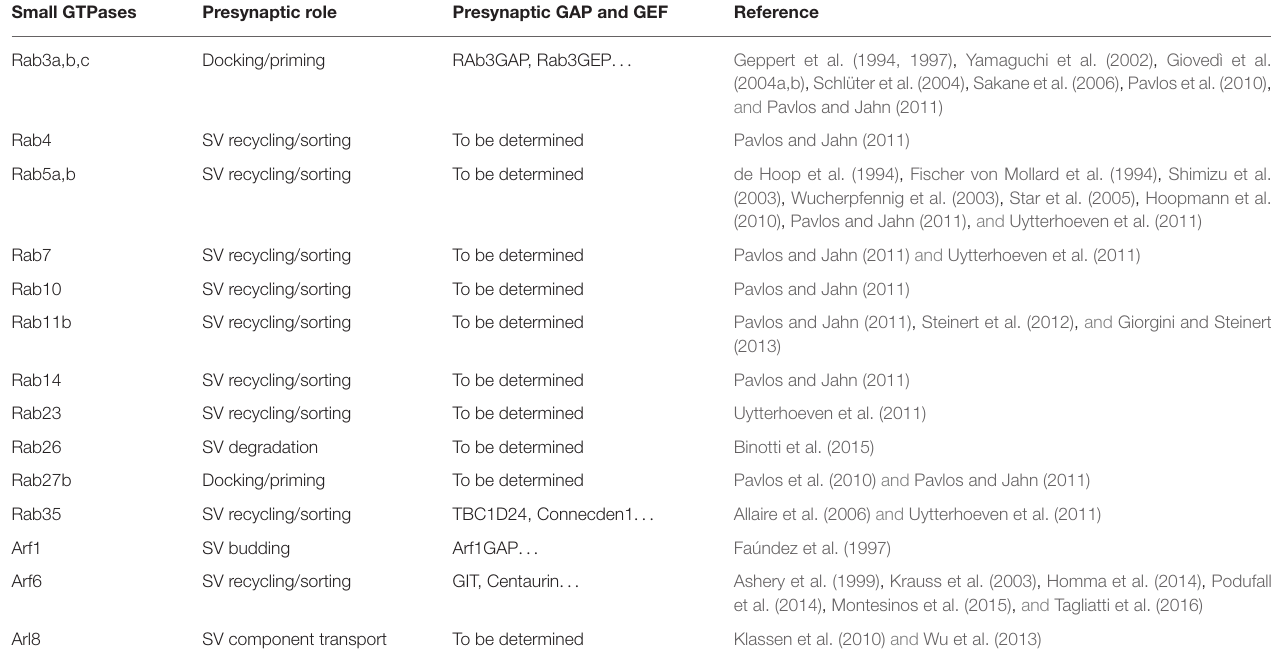
TABLE 1 | Small GTPases playing a role at the presynaptic terminal. Small